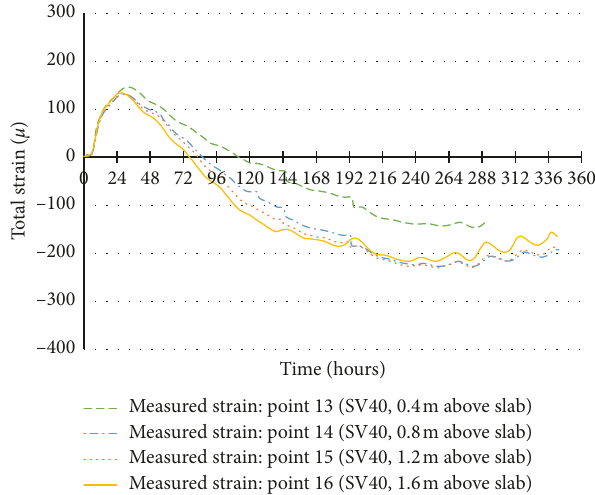
Figure 7: Measured total strain development in the middle section of the SV40 wall.